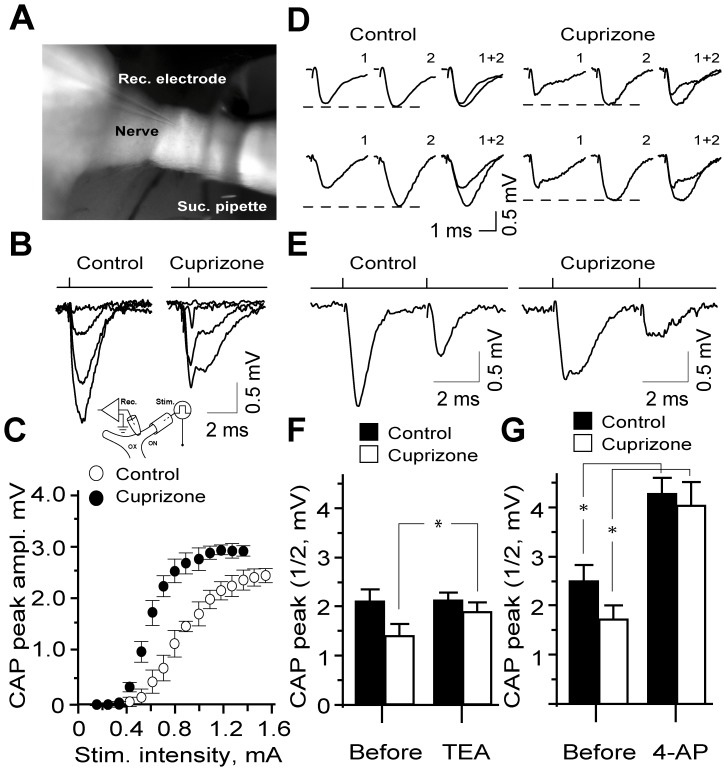
Demyelination disrupts the conductivity of ON axons which can be partially restored by 4-AP.(A, B) A low magnification micrograph (4×) demonstrating the semi-dissected ON (ventral view) with stimulation (suction, Suc. pipette) and recording (Rec.) electrodes. Graded synchronous CAPs recorded from control animals contrasting with bi-component CAPs derived from experimental ON activated from elevated stimuli thresholds (C). Insert illustrates the experimental set-up for CAPs recordings. Rec. - recording electrode; Suc. - suction pipette used for stimulation. ON – optic nerve, OX – optic xiasm. (B) Typical CAPs evoked in control ON by paired-pulse stimulation (PPS). Note the second CAP from the refractory phase following the first CAP. The evoked CAPs recorded from cuprizone-treated (demyelinated) ON axons showed lower amplitudes and protracted late components compared to the untreated (myelinated) ON axons. (C) Stimulus-response relation of CAPs in controls and experimental ON, showing lower activation threshold and higher amplitudes of evoked CAPs in demyelianted ON. (D) Representative recordings of CAPs from ON of control and cuprizone fed mice before (1) in the presence of TEA (2, upper row) or 4-AP (lower row) and (1+2) superimposed traces. (F, G) Summary of the effects of TEA (15–20 min application) on the CAPs in control and cuprizone-treated ONs (n = 5 in each group) (E) The summary histogram of CAP amplitudes scored before and after application of 1 mM 4-AP. Note the significant enhancement of the CAP amplitudes in demyelinated ON caused by 4- AP (P<0.05, n = 5 in each group).